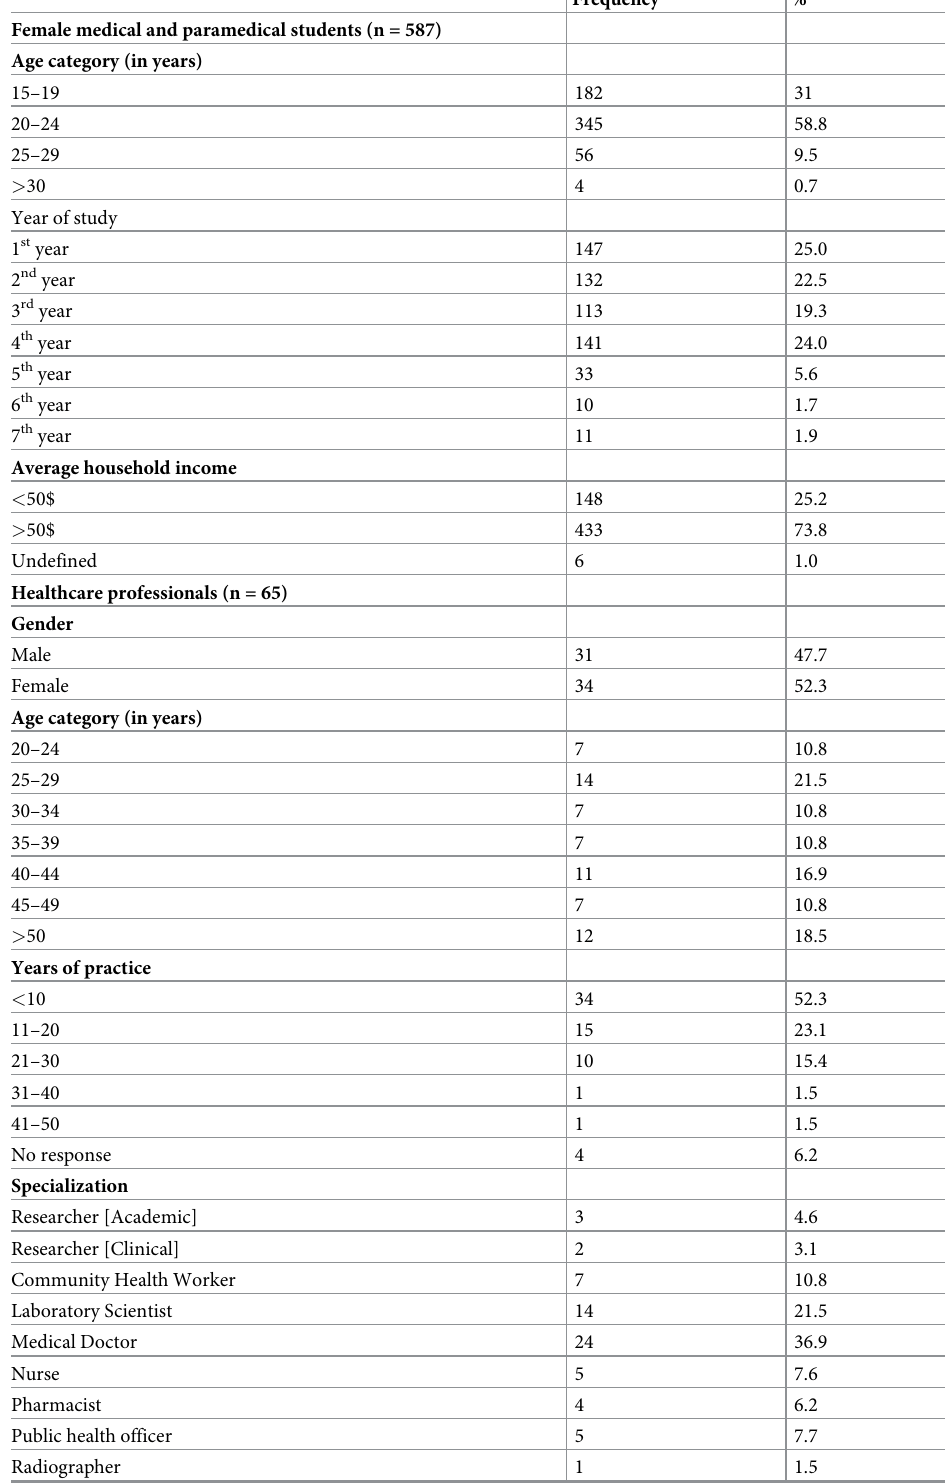
Table 1. Demographic characteristics of the study